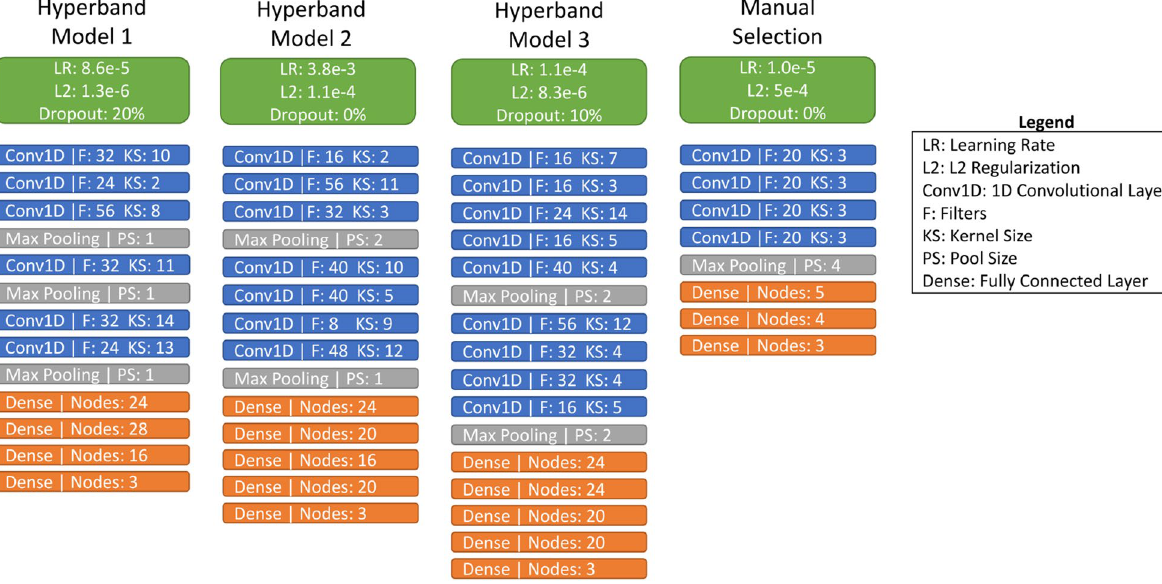
Figure 9. Architectures of the top 3 performing models selected by Hyperband and the architecture resulting from manual hyperparameter selection.